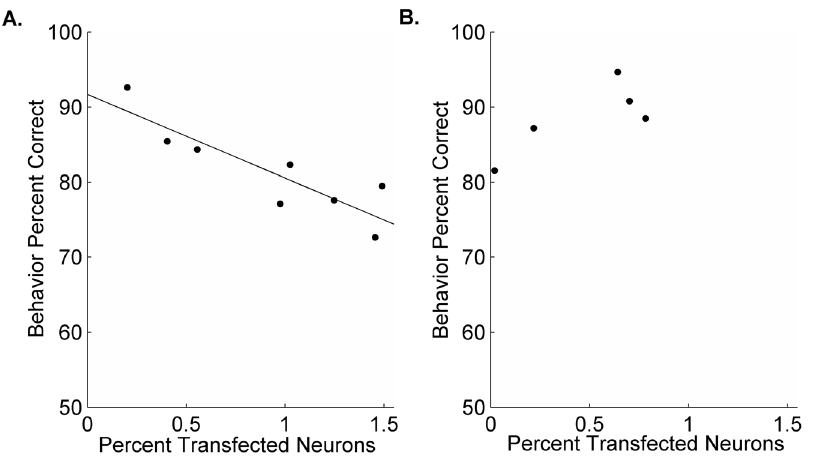
Figure 3. Percentage of transfected neurons predicts behavioral aptitude in KIA- rats. Correlation line denotes significance. A . The percentage of layer 2/3 pyramidal neurons affected by the transfection was calculated in A1 bilaterally. In KIA- rats, a higher percentage of transfected neurons was strongly correlated with impaired behavioral performance on the last day of full speech training (R= 2 0.66, p , 0.01). B . The percentage of transfected neurons in control animals was not correlated with performance (R=0.88, p=0.12).